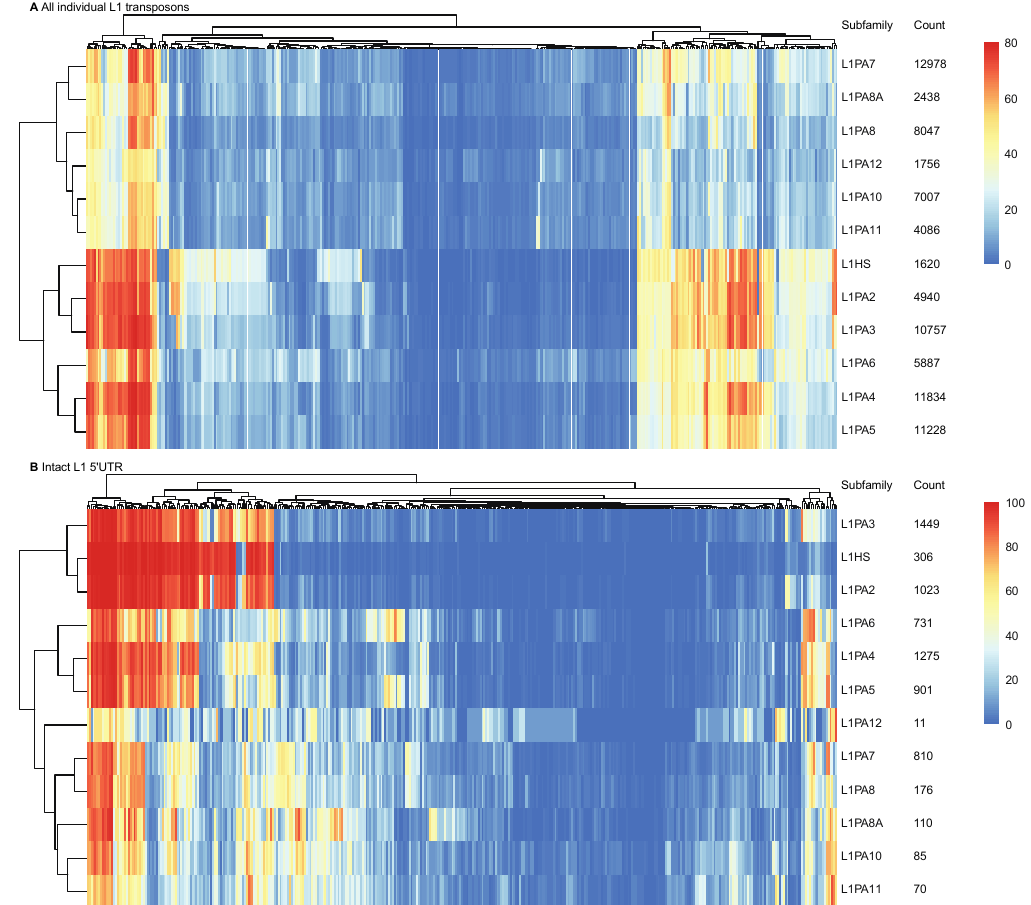
Figure 1. Different primate-specific L1 subfamilies were predisposed to different TF binding profiles. Motif scanning analysis was performed on ( A ) all individual transposons and ( B ) L1 5 (cid:48) UTRs. Heatmaps show the hierarchical clustering performed on the occurrence frequencies of each TF motif (columns), using pheatmap (clustering_method = “complete”). The total count of L1 transposons and intact 5 (cid:48) UTRs of each subfamily are shown.